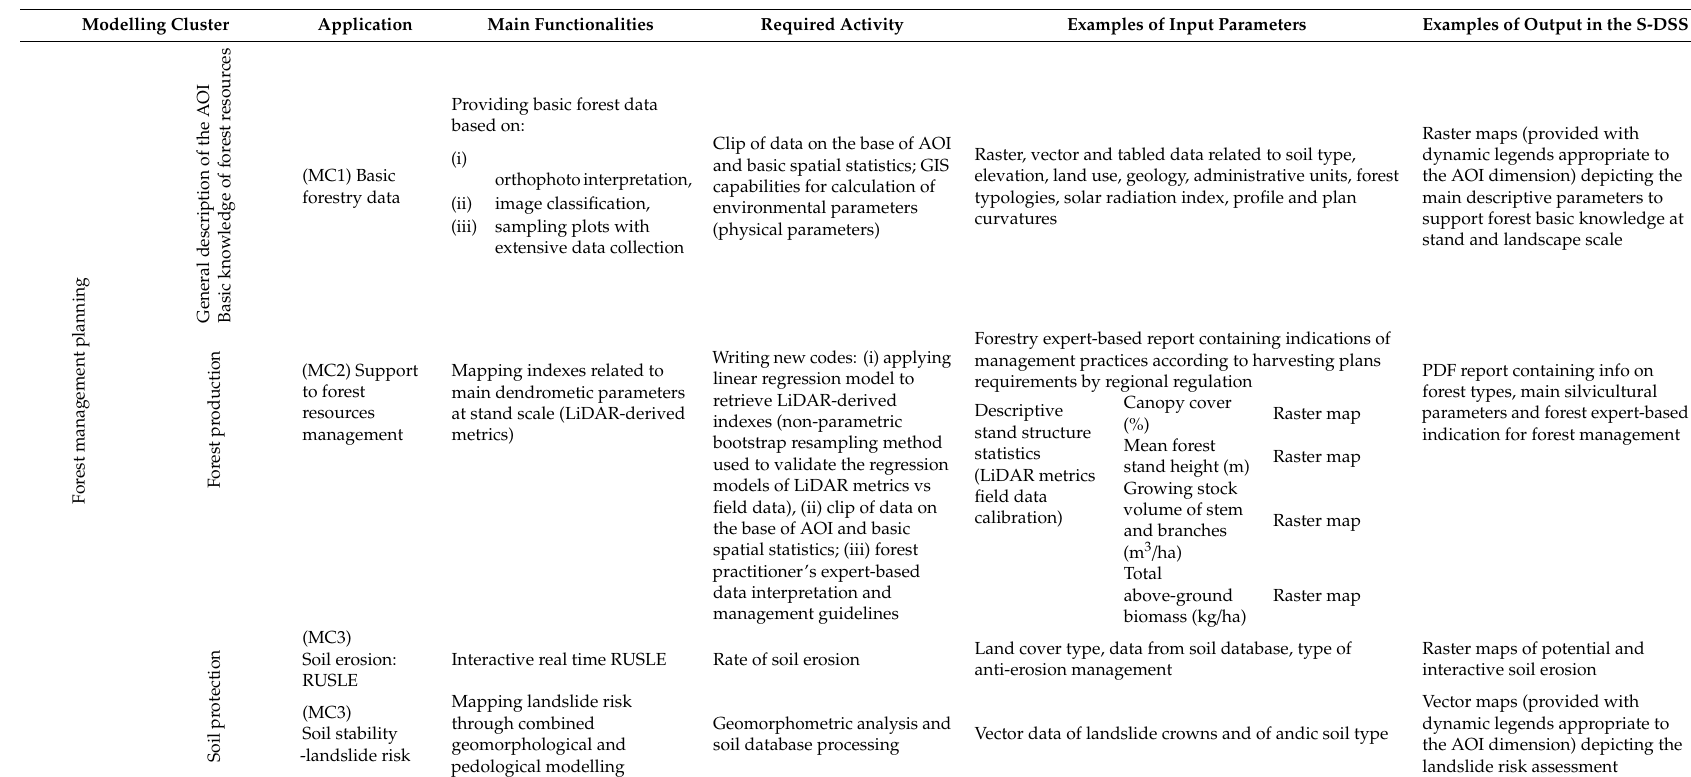
Table 2. Main models employed in SOILCONSWEB-GCI for the forestry tool: description of modelling cluster and examples of their use / importance. Modelling